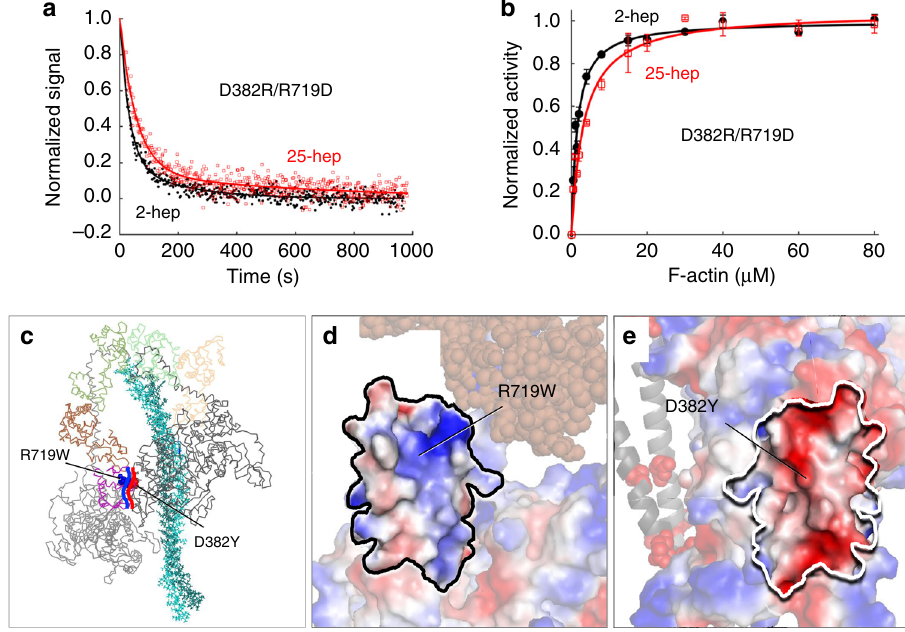
Fig. 6 Effect of double switch mutation D382R/R719D on HMM ATPase kinetics. In all cases, black solid line and fi lled circles are 2-hep HMM data; Red solid line and empty squares are 25-hep HMM data. a Mant-nucleotide single turnover kinetics for D382R/R719D 2-hep and 25-hep HMM. b Actin- activated ATPase data for D382R/R719D 2-hep and 25-hep HMM. a Shows representative data from one preparation each. Panel b is combined from two independent preparations of HMMs with three experimental replicates for each preparation. Each point is an average with the error bar representing the SEM. c Model of the front-side view of the human β -cardiac myosin IHM (MS03 homology model, downloadable at https://spudlab.stanford.edu/ homology-models/) 26 , with the two S1 heads and the light chains shown as lines, and the S2 tail region represented by sticks. The Arg719 residue (blue) is part of the free head converter (purple) and the Asp382 (red) residue is part of the blocked head PHHIS. The heavy blue curved line indicates the generally positive surface of the free head converter that interacts with the generally negative blocked head PHHIS surface, marked by the heavy red curved line. d The image in c rotated 90° counterclockwise about the vertical axis de fi ning the binding interface. The free head converter-binding interface, shown in vacuum-electrostatics mode in PyMOL, is generally positively charged. e The image in c rotated 90° clockwise about the vertical axis de fi ning the binding interface. The blocked head PHHIS-binding interface, shown in vacuum-electrostatics mode in PyMOL, is generally negatively charged. Source